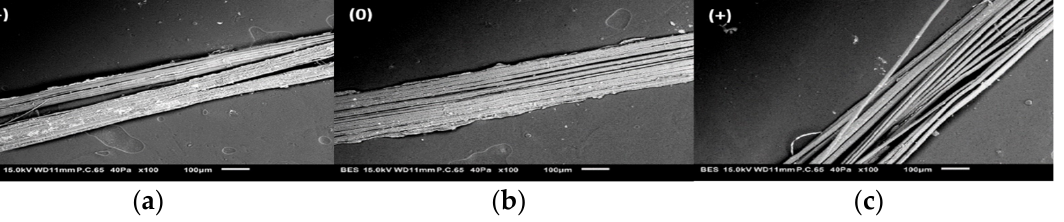
Figure 9. SEM pictures of flax technical fibers ( a ) retting ( − ), ( b ) retting (0), ( c ) retting (+), (magnification X100) .